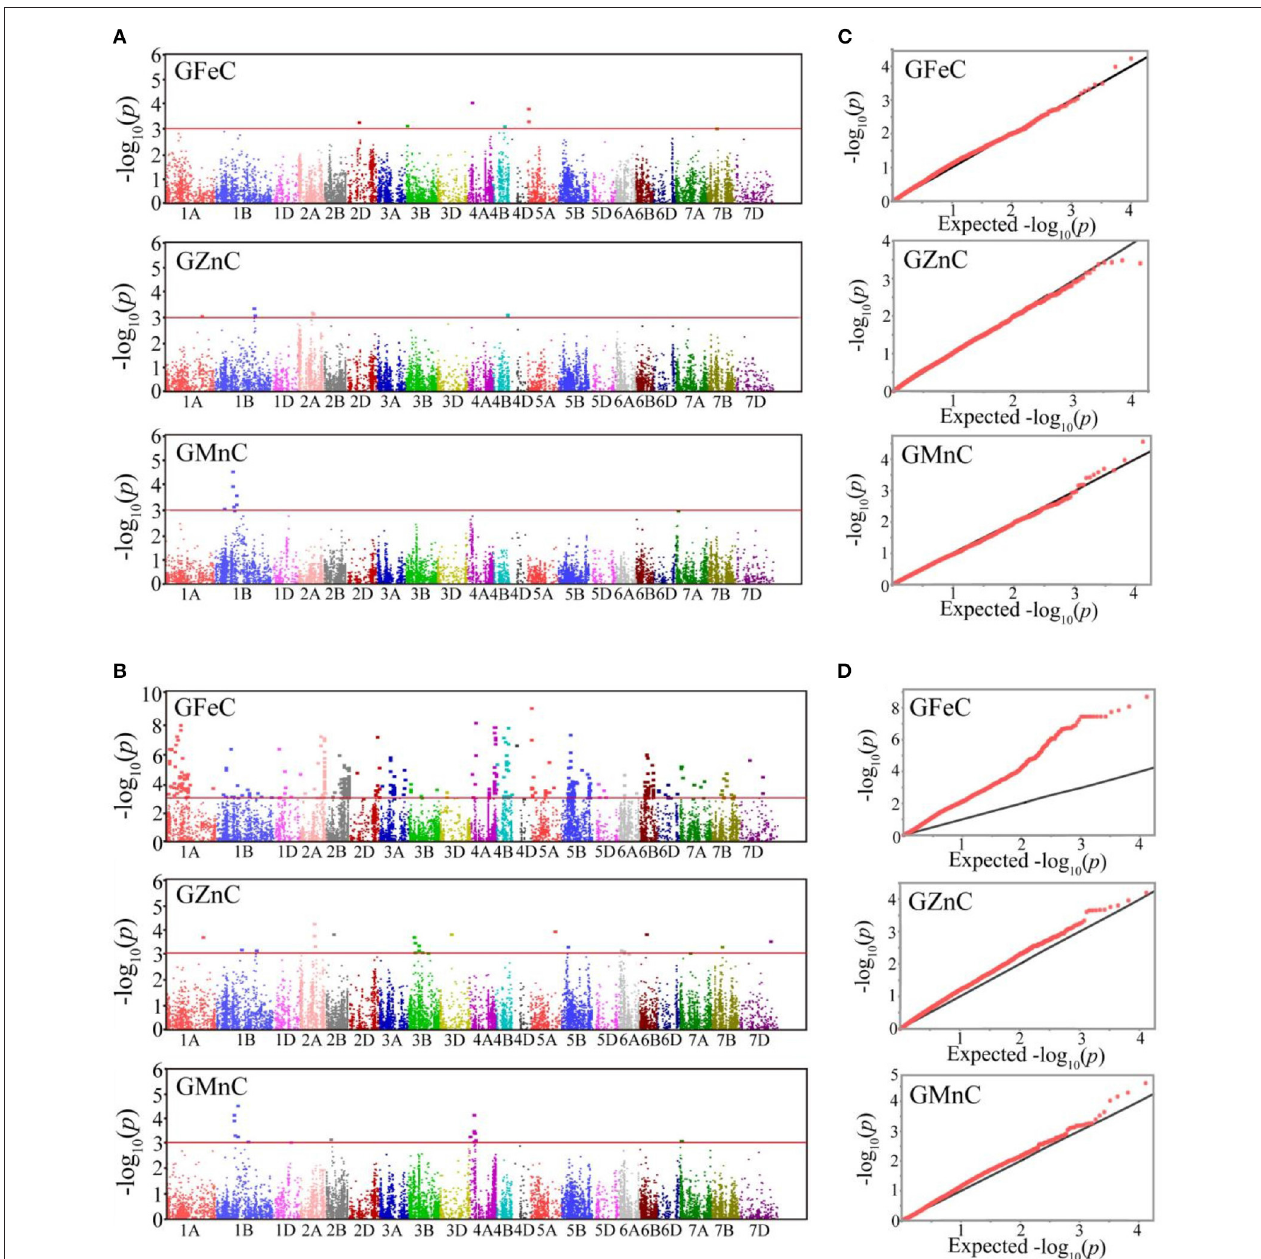
FIGURE 3 | Manhattan plots of GWAS scan for GFeC, GZnC, and GMnC in four environments. Significant MTAs identified by MLM (A) and GLM (B) . Red lines: the –log 10 ( p ) threshold of 3.00. The quantile-quantile charts of MLM (C) and GLM (D) . Black line: the expected values.